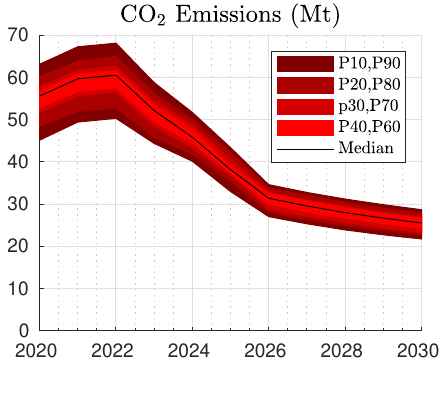
Figure 6. Performance indicators for transition path A .